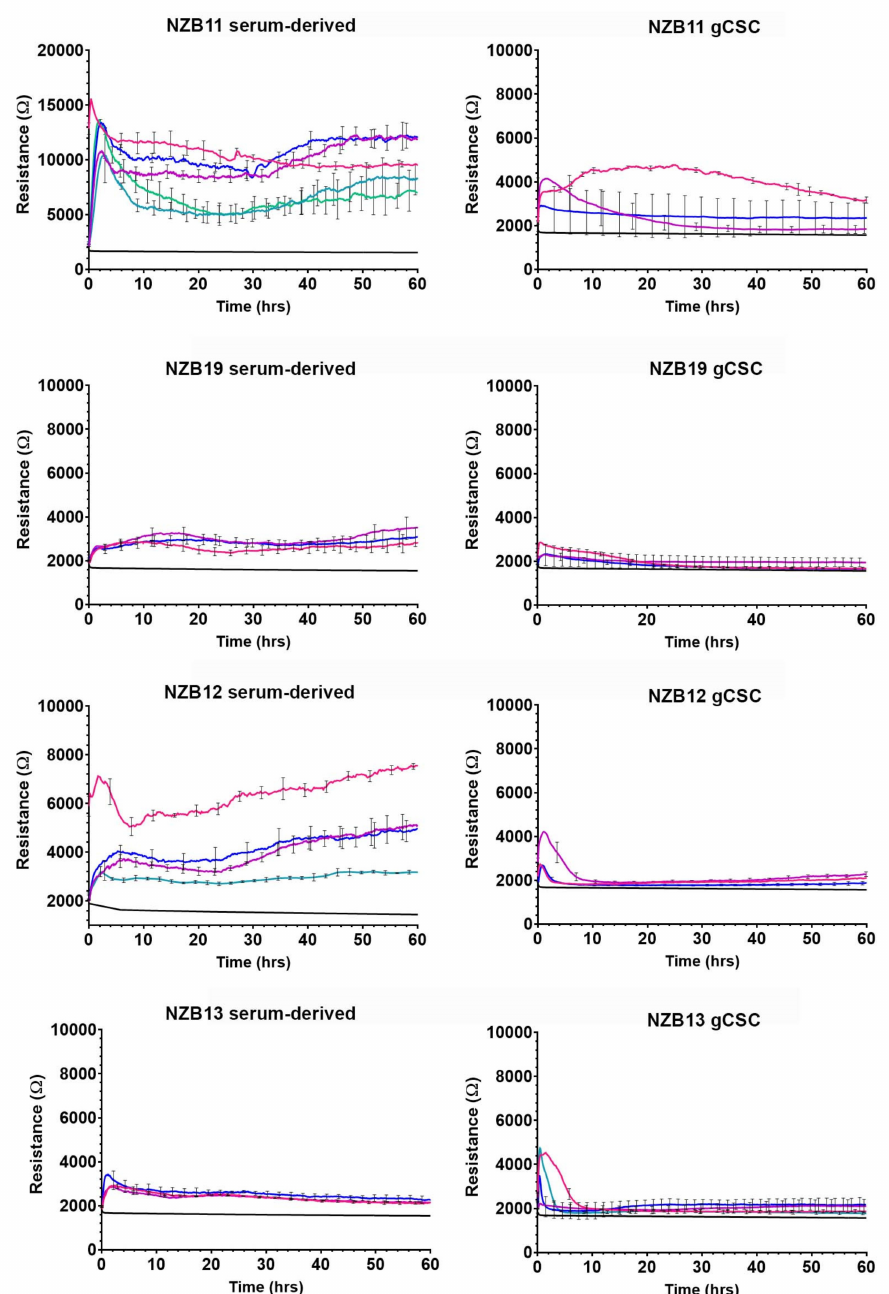
Figure 5. Representation of inter-experimental variability of serum-derived and gCSC cells grown on 96W1E+ ECIS arrays. Resistance measurements at 4000 Hz over 60 h of growth. Comparison of adhesion of NZB11, NZB12, NZB19, and NZB13 serum-derived and gCSC cells seeded at 80,000 cells. Growth profiles, referenced against a cell-free control well (black line), are shown. Each coloured adhesion profile represents an independent